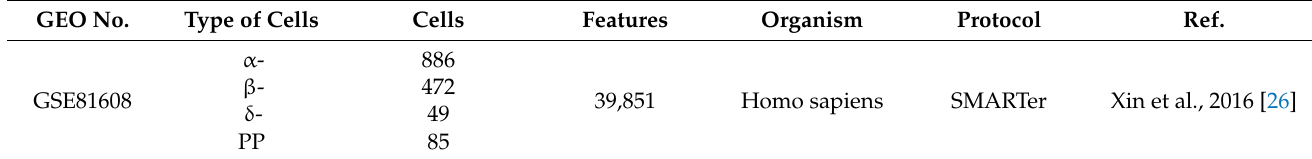
Table 1. We downloaded the data from the NCBI Gene Expression Omnibus (GEO) reposi- tory with accession ID GSE81608. After the data preparation, we used the Seurat method (https://satijalab.org/seurat/index.html (accessed on 1 September 2020)) for quality con- trol, normalization, data exploration, and visualization of the preprocessing steps [25]. Table 1. Summary of single-cell data information in the proof-of-concept study. GEO No. Type of Cells Cells Features Organism Protocol